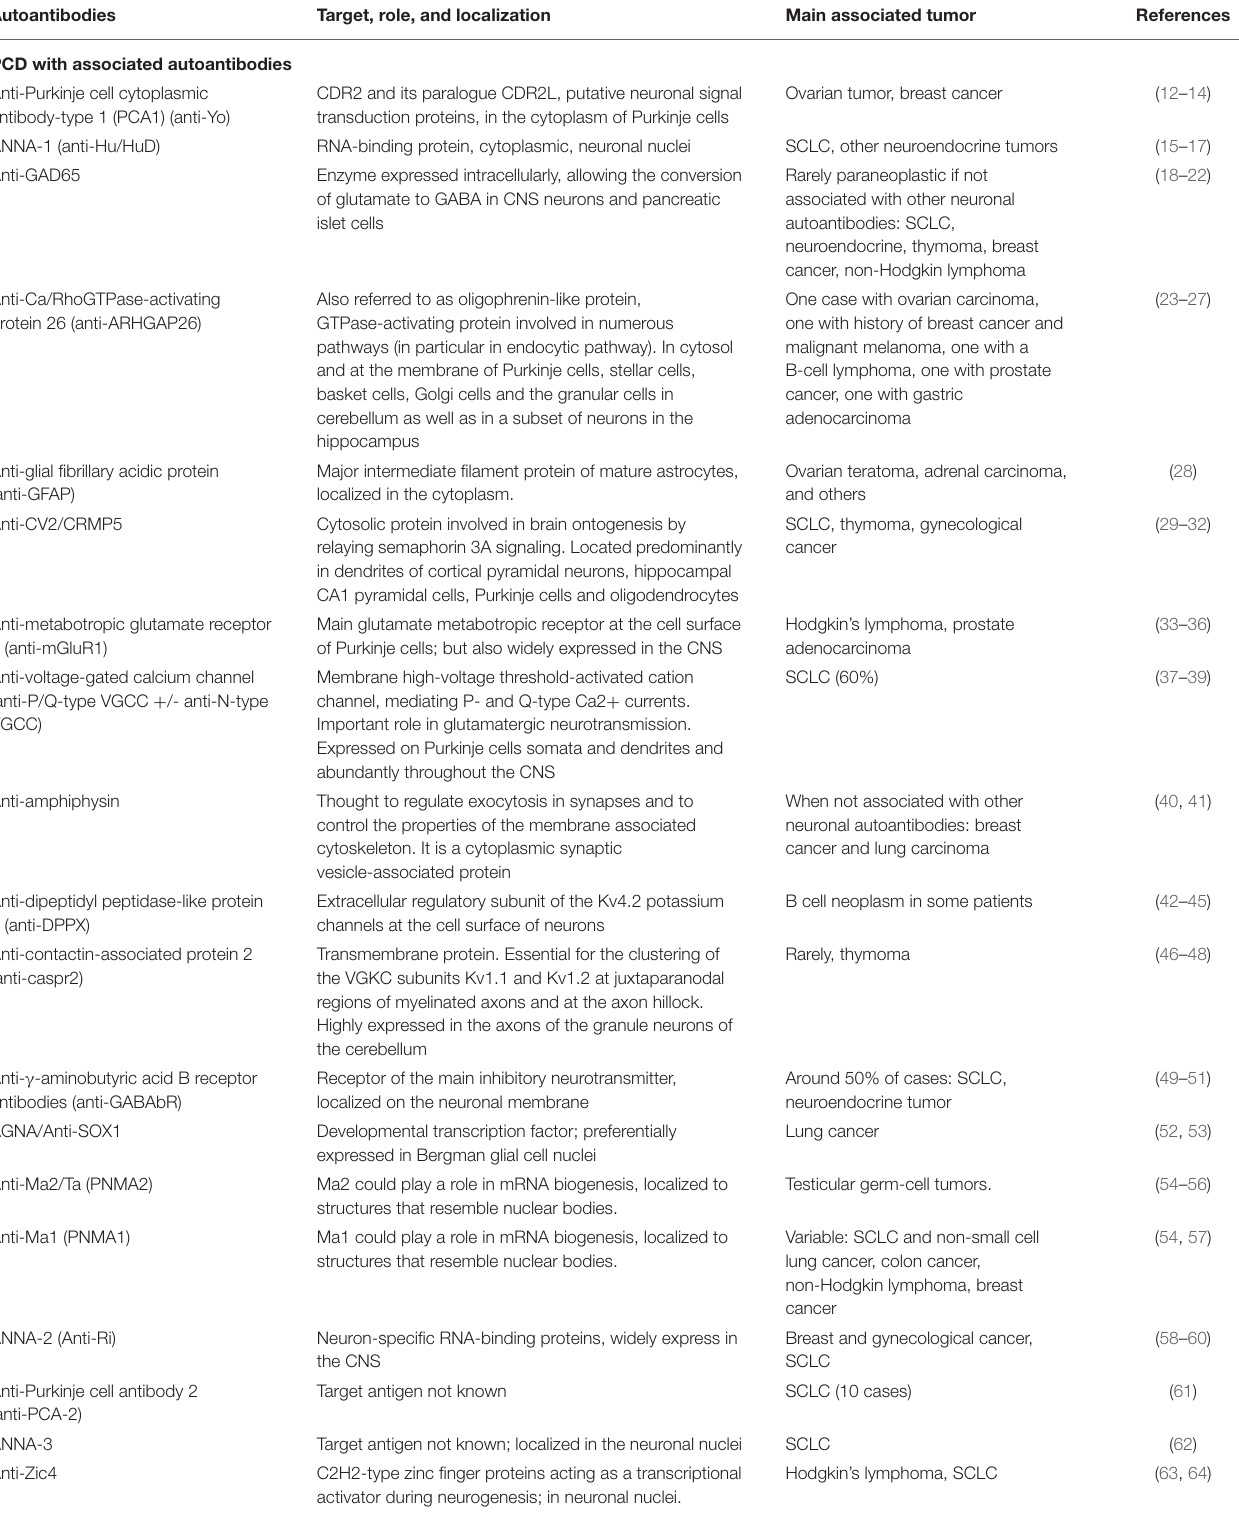
TABLE 1 | Main autoantibodies reported in paraneoplastic cerebellar